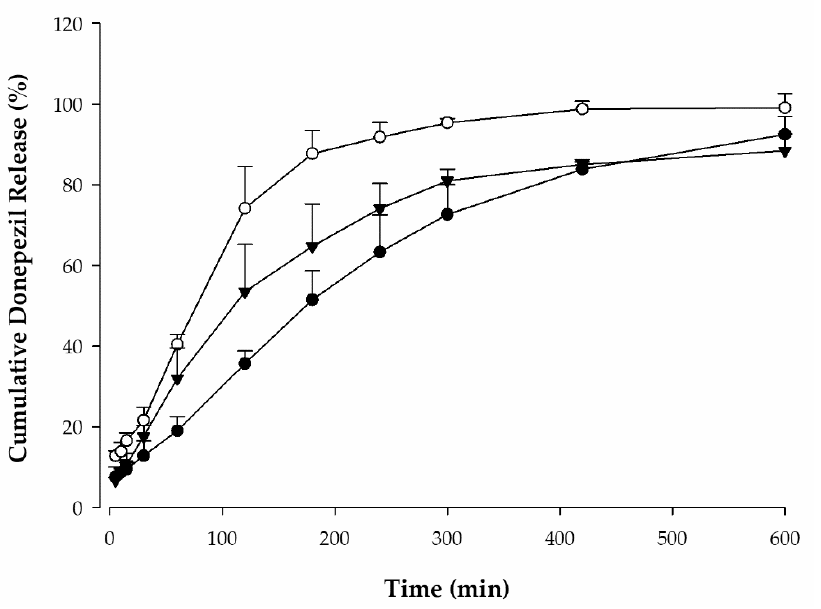
Figure 7. Cumulative donepezil release from donepezil-loaded DMN patches. F1 ( ● ), F2 ( ○ ), F3 ( ▼ ). (mean ± standard deviation, n = 3).